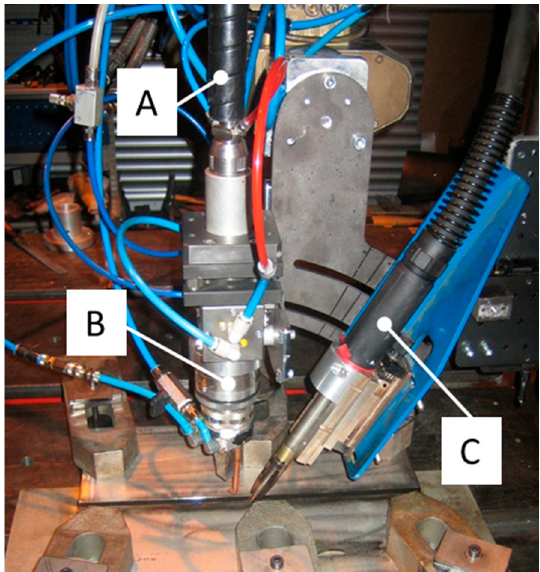
Figure 2. Welding head set-up used in the laser-arc hybrid and laser cold-wire experiments. ( A ) process fibre with connector; ( B ) laser welding head-unit; ( C ) adjustable gas metal arc welding (GMAW) torch unit.